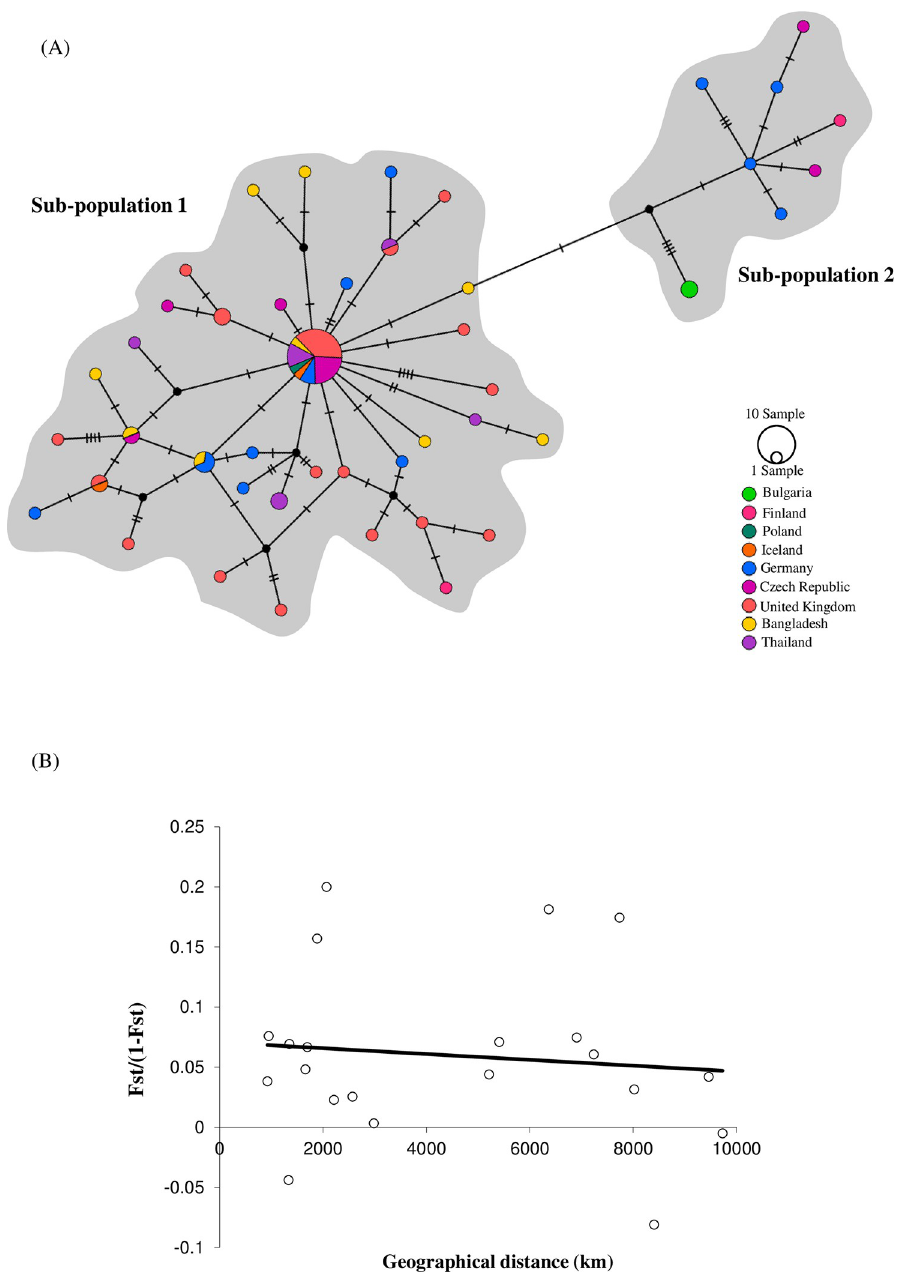
Fig 3. Divergence of populations of Echinostoma revolutum (s.s) across Eurasia. (A) Haplotype network based on the most parsimonious geneology of nad 1 sequences of E . revolutum ( s . s .) from across Eurasia. Pie charts are scaled to represent the number of individual parasites sharing a particular nad 1 haplotype (see scale for sizing); colours indicate geographical location (key); black circles represent hypothetical ancestral haplotypes. (B) Mantel test regression analysis showing a lack of significant correlation between genetic distance and geographical distance between E . revolutum ( s . s .) isolates across